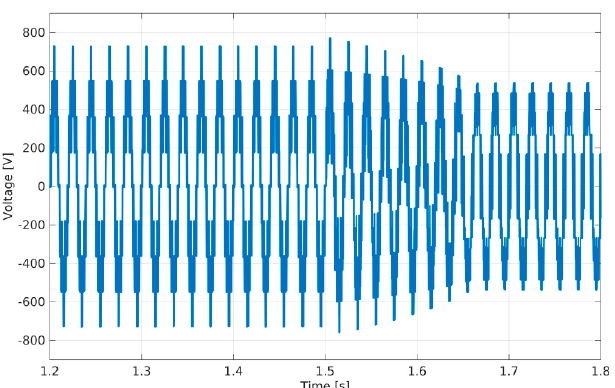
Figure 15. Motor three-phase currents with a voltage sag of 70% and with the increase in the voltage of the floating capacitor.